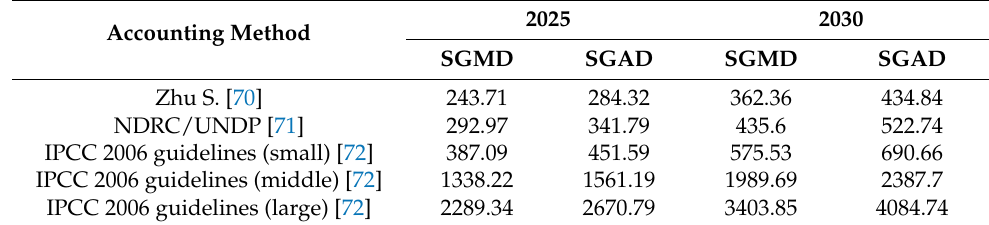
Table 3. Total methane emissions (kt).